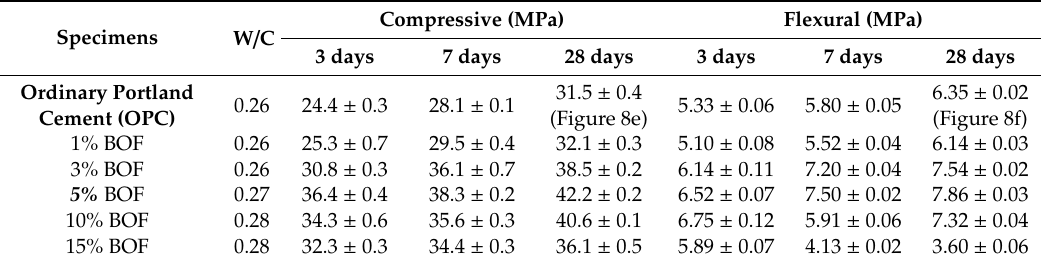
Table 2. Compressive and flexural strengths for BOF-enhanced cement and OPC mortar specimens with associated standard error (standard